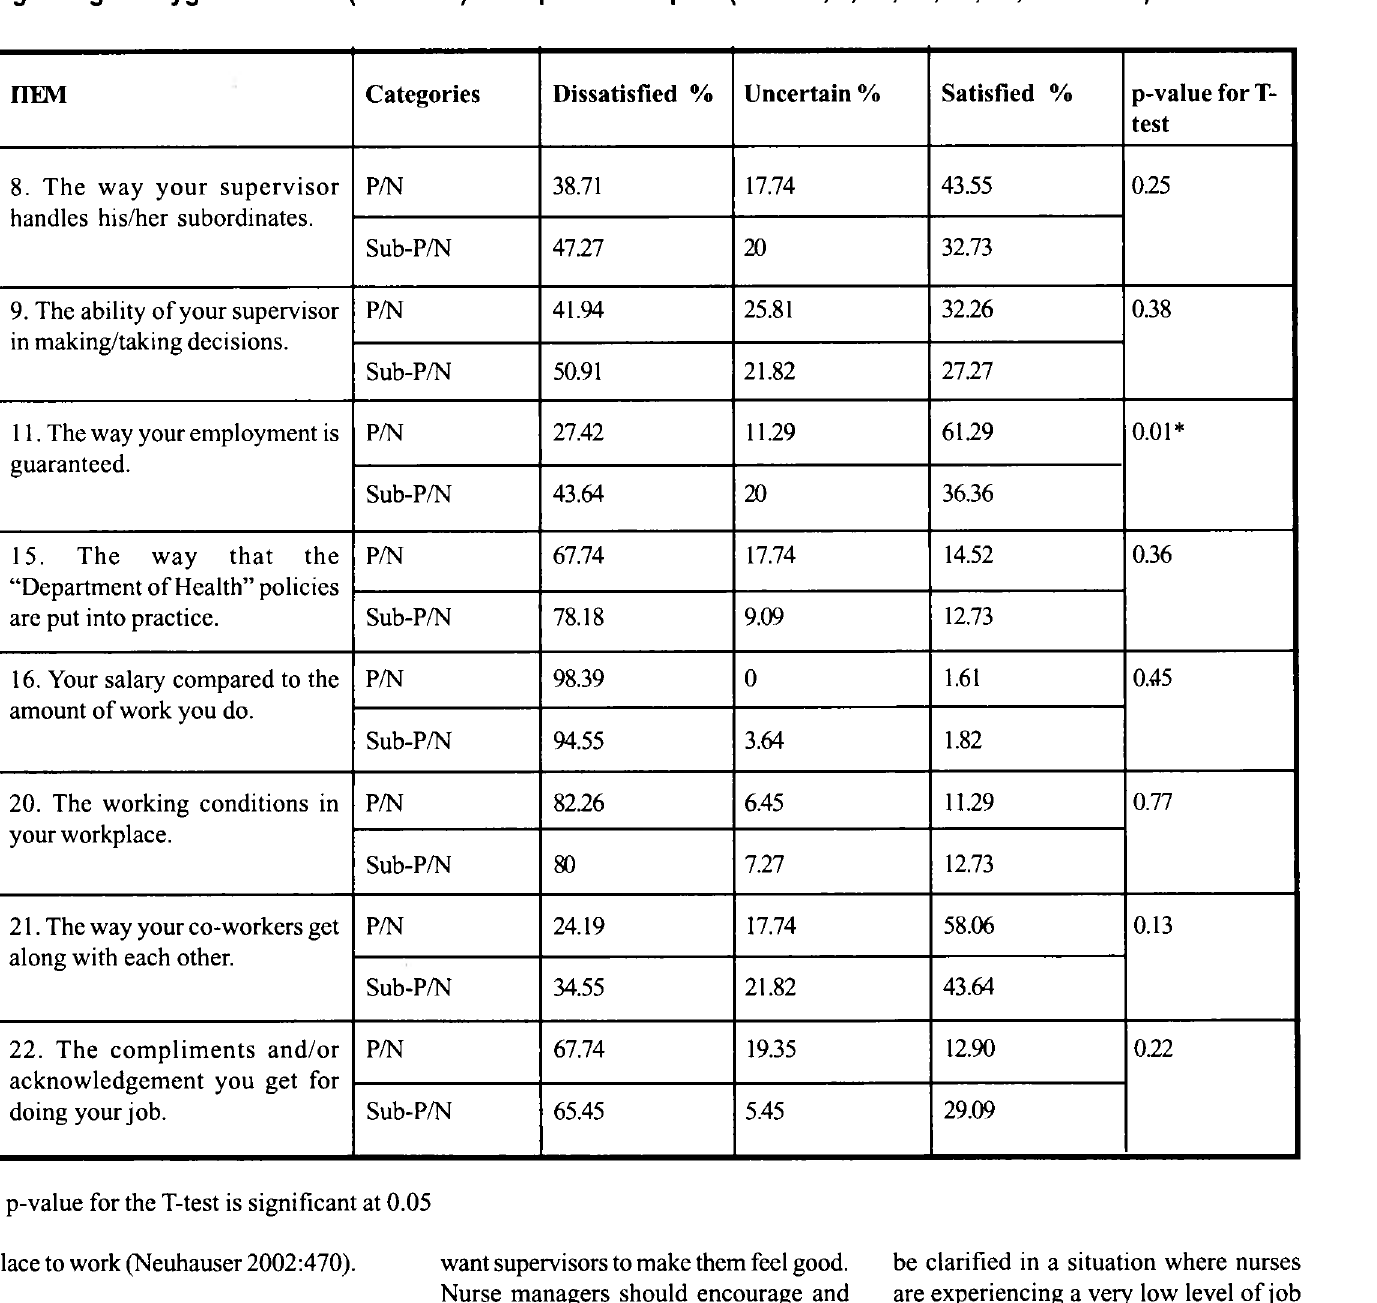
Table 4: A comparison of satisfaction between Professional (pin) and Sub-professional (sub. P/n) nurses regarding the hygiene factors (extrinsic) in a specific hospital (items 8,9,11,15,16,20,21 and